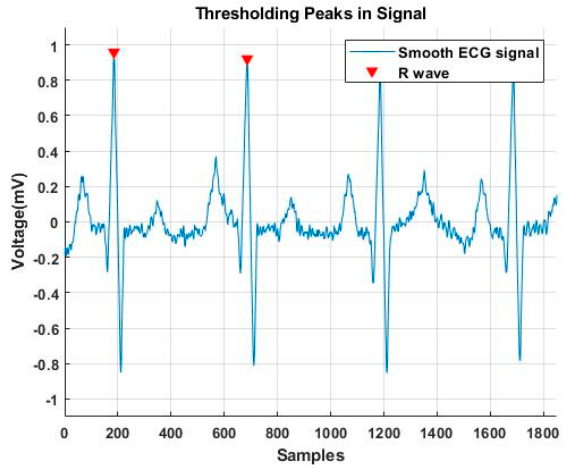
Figure 4. A sample of R-wave detection by applying the pick detection algorithm to an ECG signal.